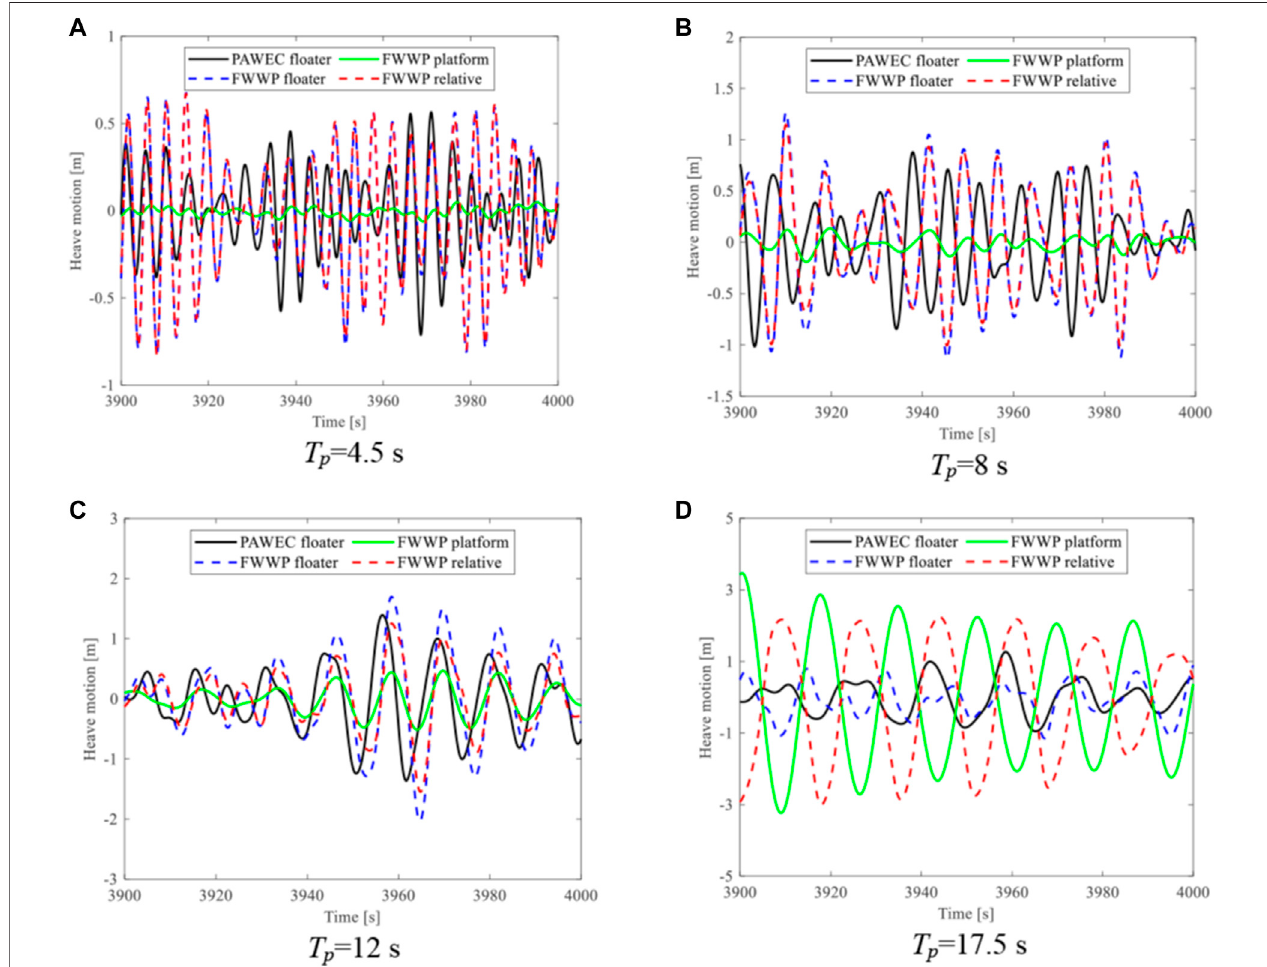
FIGURE 16 | Heave motion of the fl oater in the PAWEC, compared with the fl oater and platform and their relative motion in the FWWP under irregular wave. (A) T p =4.5 s. (B) T p =8 s. (C) T p =12 s. (D) T p =17.5